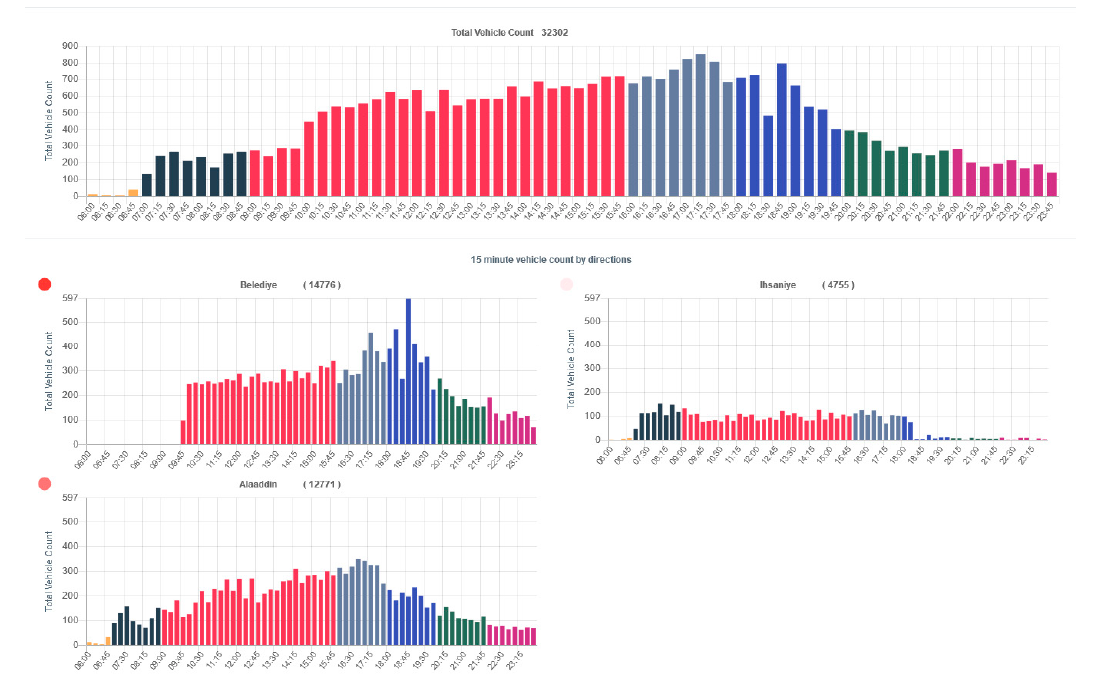
Figure 10. Number of vehicles comes from all directions to the intersection. Table 10. The 1 day performance values at Kartal Sahilyolu Junction.